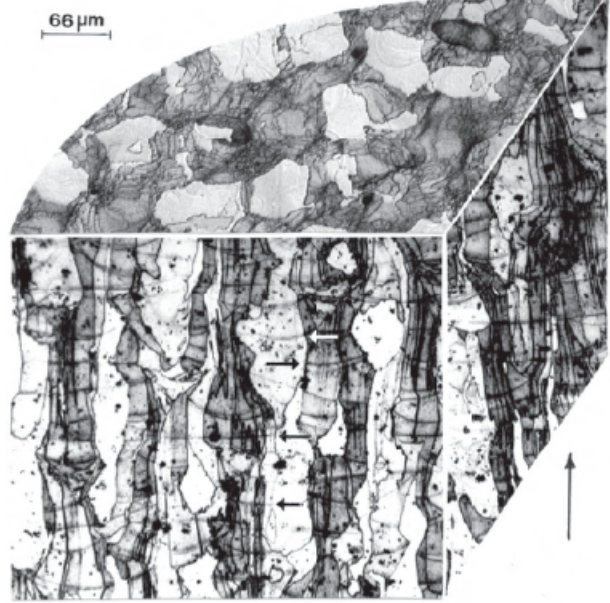
Figure 16. OM-3D reconstruction of 17-4 PH sample, effective building direction shown by vertical arrow in the lower right corner: the microstructure is fully martensitic and comes from Ar-atomized powders fabricated in an Ar-rich environment (Ar/Ar) [137].